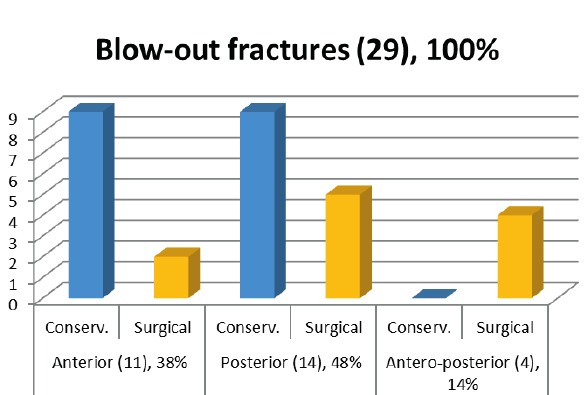
Fig. 1. Relationship between conservative and surgical therapy and fracture